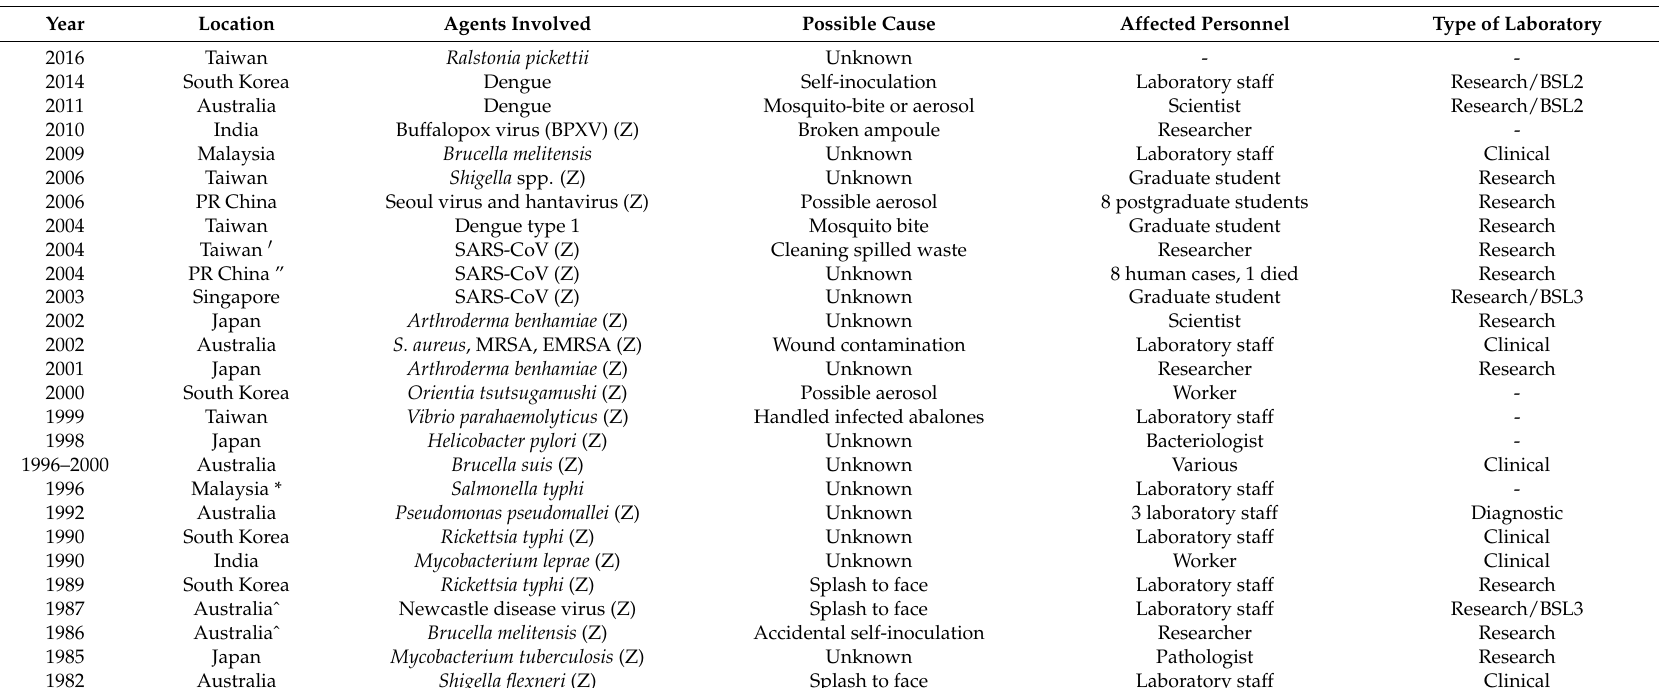
Table 1. Summary of the LAI reports in the Asia-Pacific region